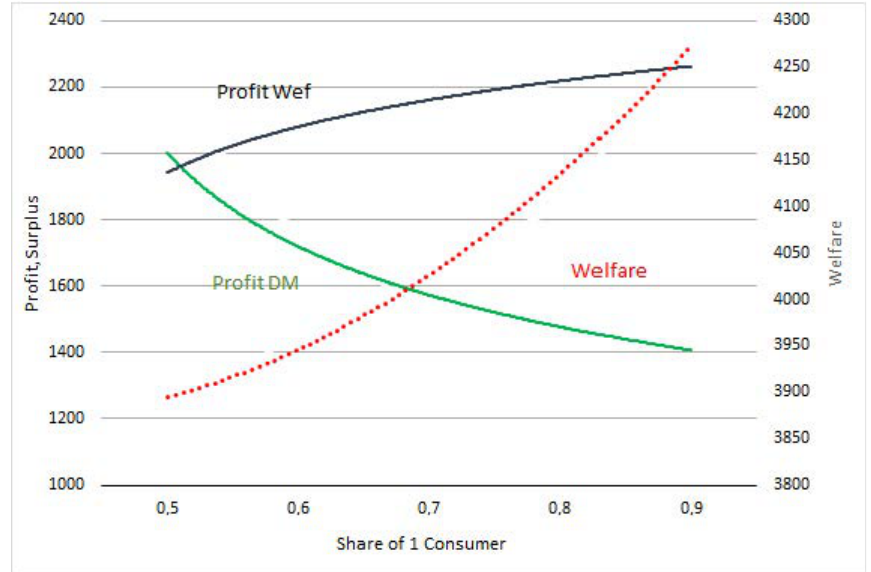
Figure 10. Load of Consumer 1 when its share when its share is 0.6 of the aggregated load.